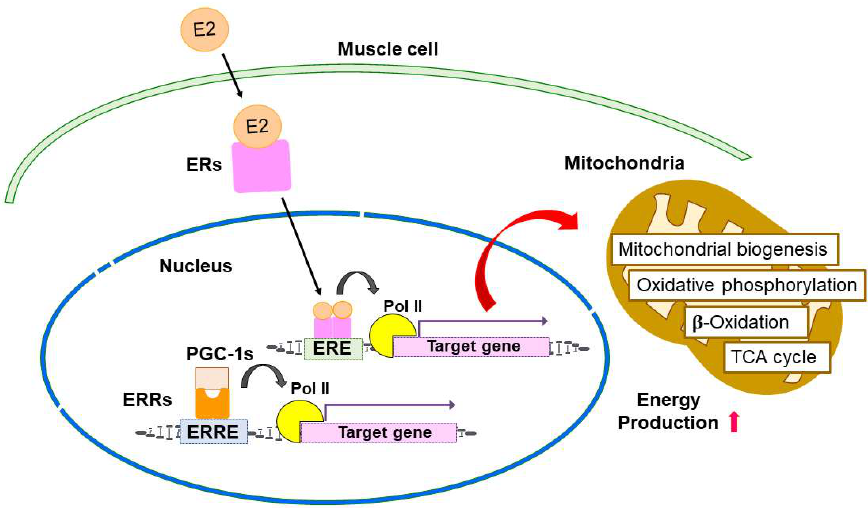
Figure 2. ERs and ERRs regulate muscle functions and mitochondrial metabolism.